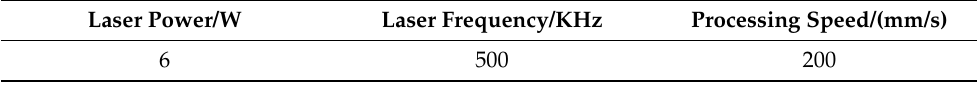
Table 13. Optimal selection of laser control